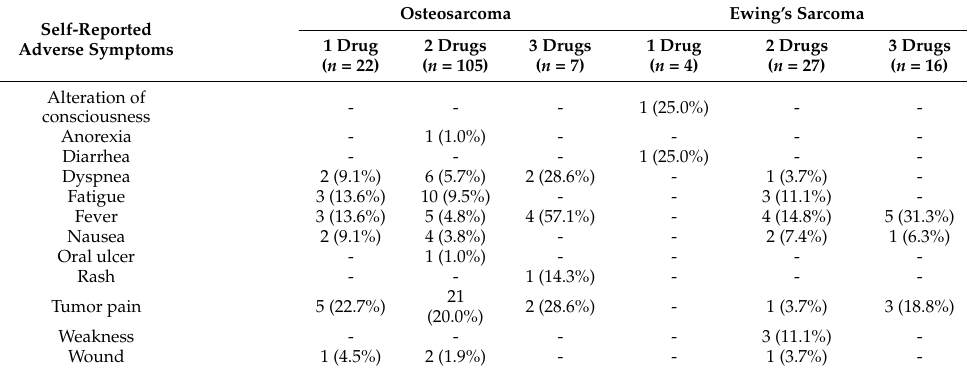
Table 4. Self-reported adverse symptoms following chemotherapy treatment. Self-Reported Adverse Symptoms